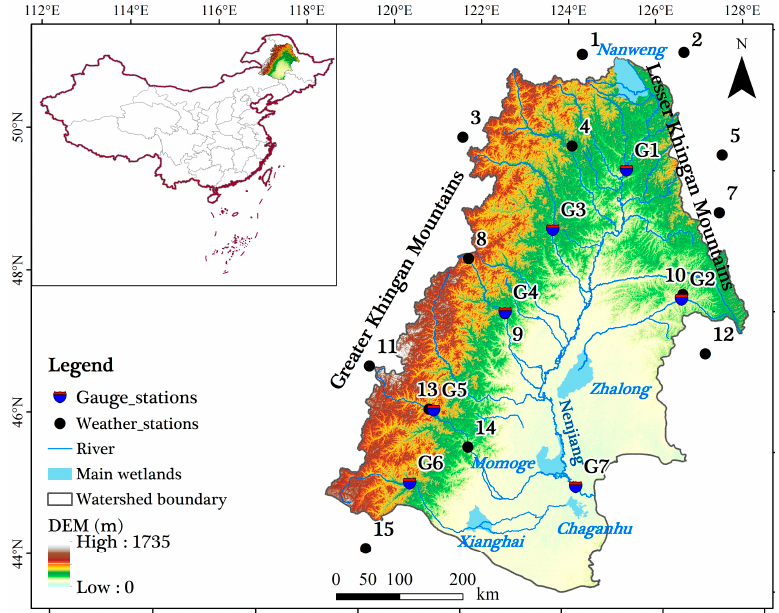
Figure 1. Geographical location of the Neijiang River Basin in Northeast China and the spatial distribution of gauge stations (black dots) and weather stations (blue-red symbol) in the basin’s headwater region used in this study.